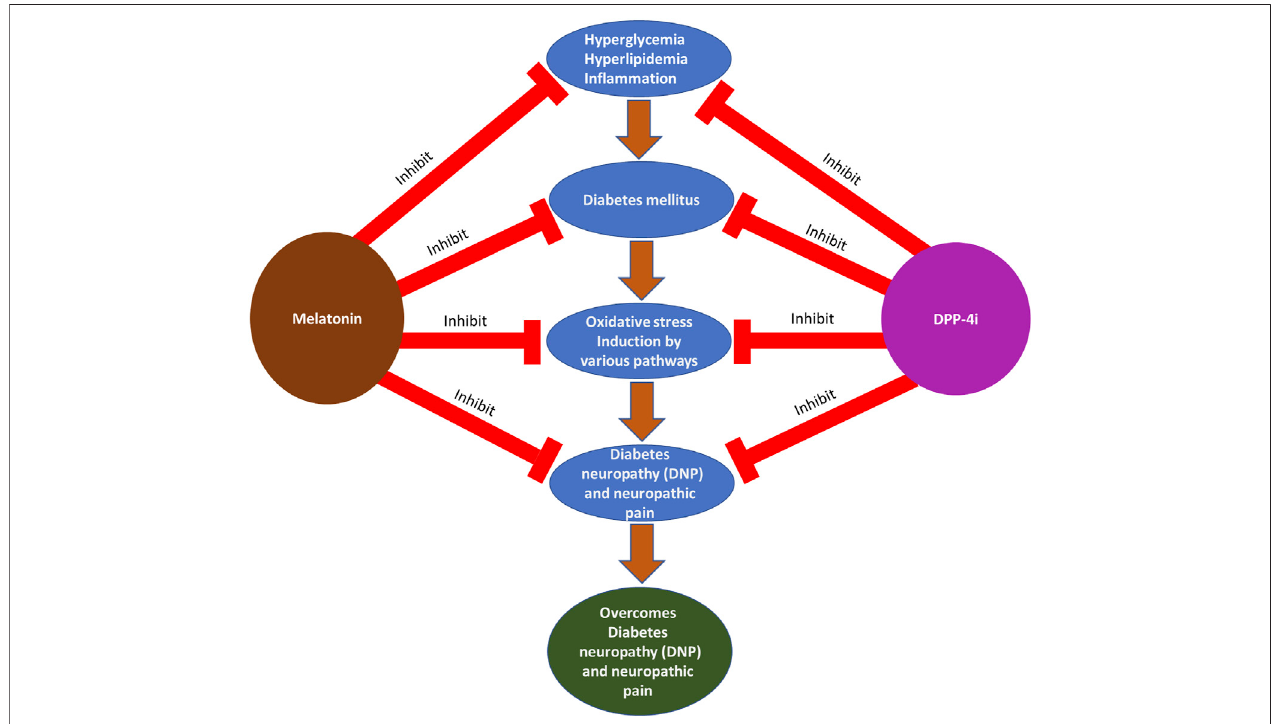
FIGURE 2 | Photographical representation of the hypothesis of DM and its complications: treatments with melatonin and DPP-4i at various stages.